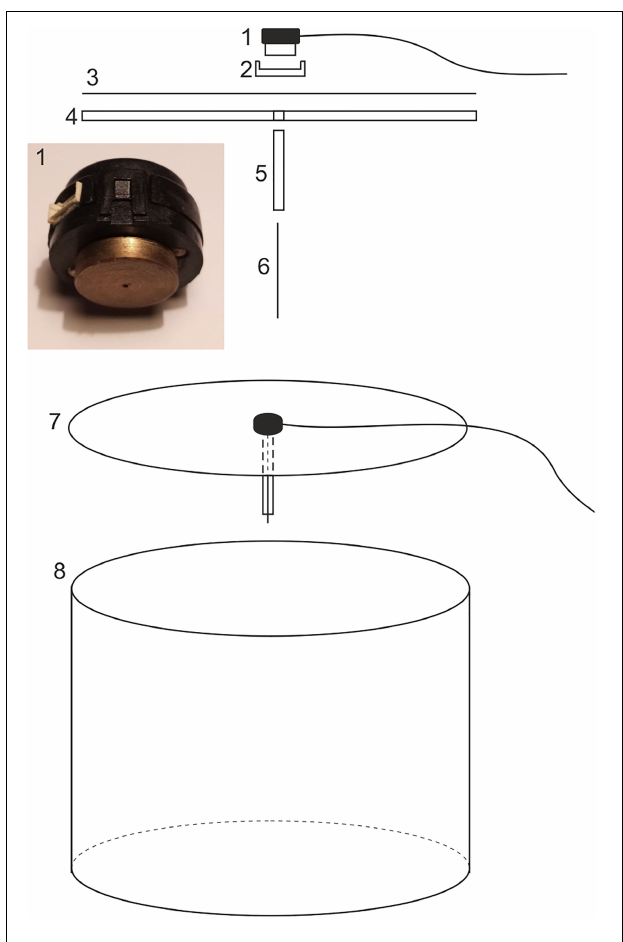
FIGURE 1 | A schematic drawing of the flight simulator showing the encoder (1), the encoder mount (2), the diffuser paper (3), the circular Plexiglass lid (4 and 7), the protective brass shaft (5), the tungsten axle (6), and the behavioral arena (8). For explanation see text.